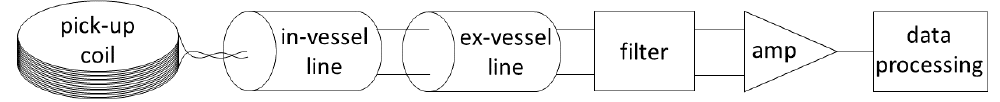
Figure 1. Schematic diagram showing the pick-up coil connected via in-vessel and ex-vessel transmission line sections to a data processing